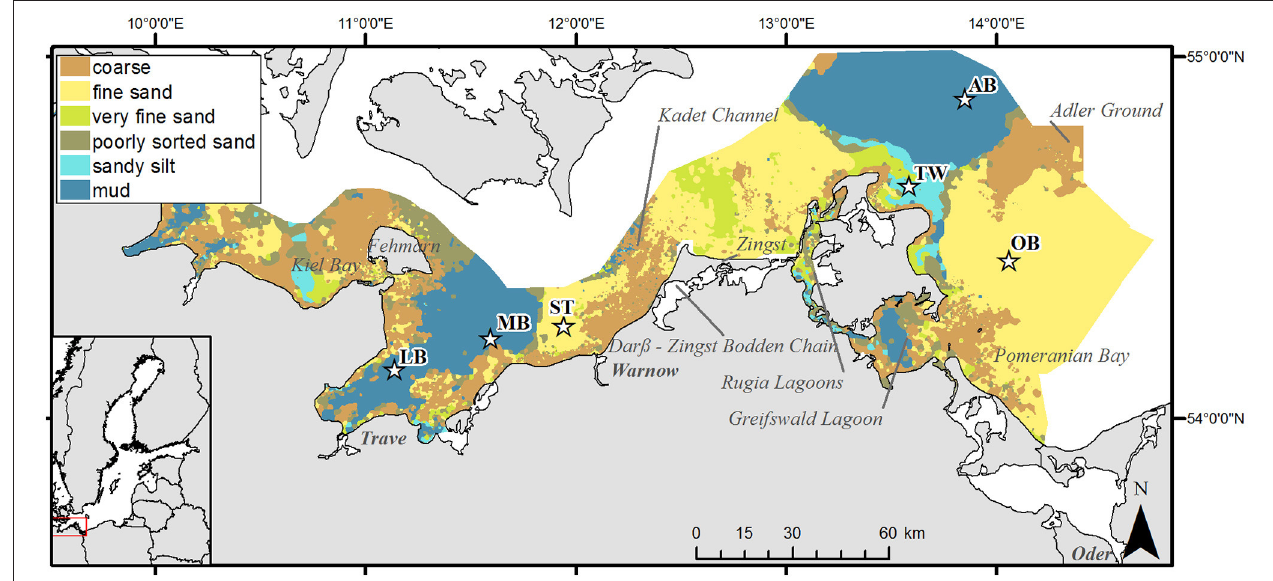
FIGURE 1 | Map of the study area in the south-western Baltic Sea with locations of sampling stations. Background colors show the distribution of sediment types after Tauber (2012). The number of cores obtained during each sampling event is given in Table 1 . Geographic locations: LB, Bay of Lübeck; MB, Bay of Mecklenburg; ST, Stoltera; TW, Tromper Wiek; AB, Arkona Basin; OB, Oder Bank.